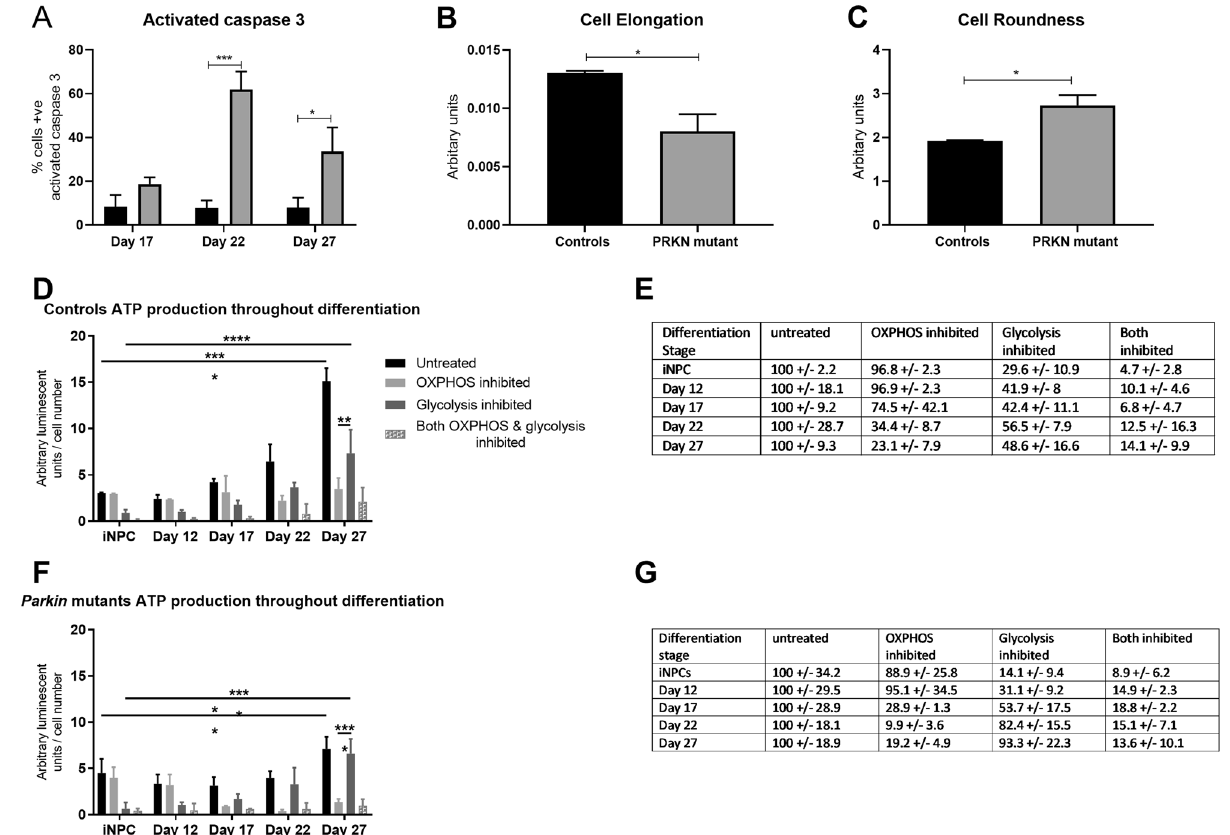
Figure 2. Neuronal morphology and metabolic status during differentiation. ( A ) Quantification of activated caspase 3 in controls (black bars) and PRKN mutants (grey bars) throughout differentiation. Significant increase in activated caspase 3 positive cells in PRKN mutants at day 22 (***p = 0.0008) and at day 27 (*p = 0.036). ( B ) A measure of cellular elongation; the PRKN mutant patient neurons have reduced cellular elongation compared to controls (*p = 0.029). ( C ) A measure of the roundness of the cells. The PRKN mutant patient neurons are more round than control neurons (*p = 0.029). ( D , E ) ATP production dependent on glycolysis or